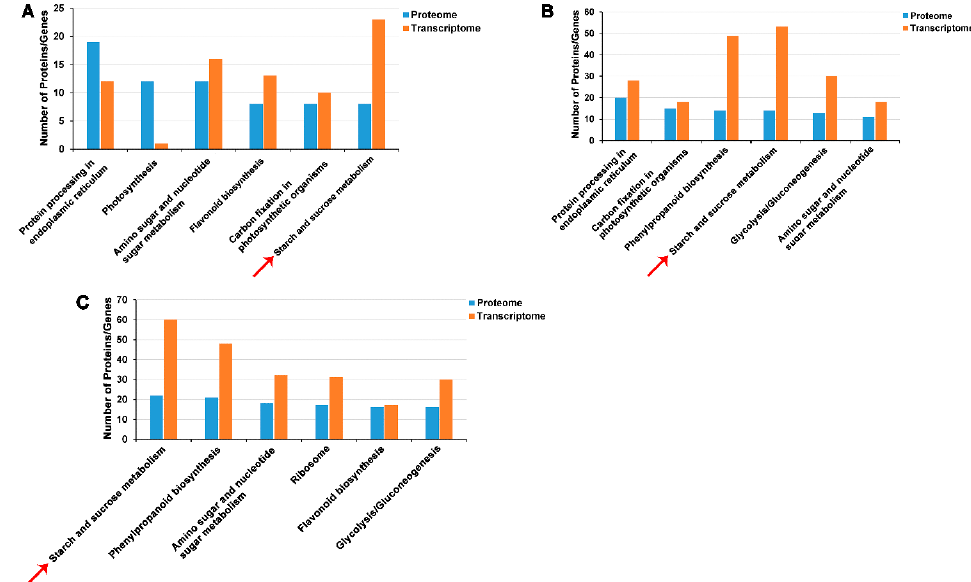
Figure 9. Combined enrichment of proteome and transcriptome in FBE vs. FBD, FA vs. FBE, and FA vs. FBD. ( A ) Combined enrichment of proteome and transcriptome in FBE vs. FBD. ( B ) Combined enrichment of proteome and transcriptome in FA vs. FBE. ( C ) Combined enrichment of proteome and transcriptome in FA vs. FBD. Starch and sucrose metabolism is marked by red arrows.